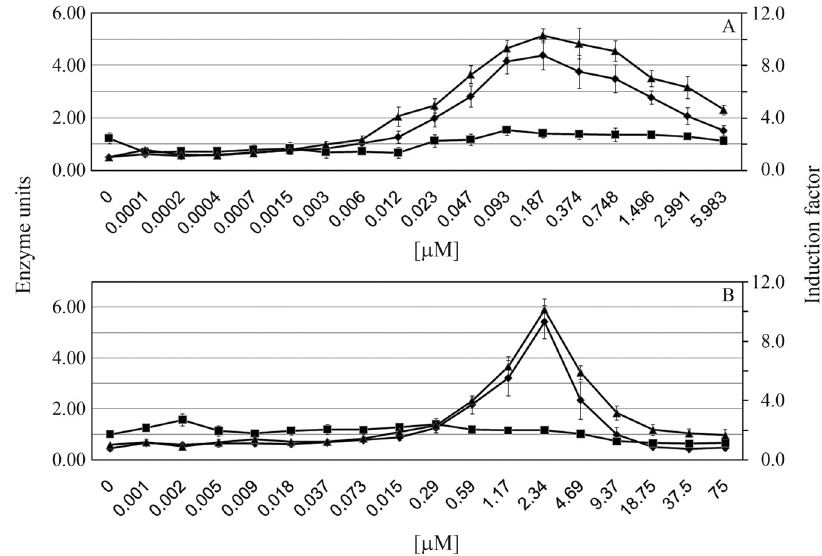
Figure 1 - Induction kinetics of the sulA gene in response to mutagens MMC (A) and 4-NQO (B) in E. coli PQ37 cells. ( ■ ) alkaline phosphatase, ( (cid:2) ) (cid:2) -galactosidase and ( ▲ ) SOS induction